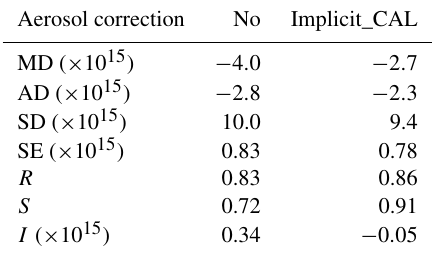
Table 5. Similar to Table 4 but for different aerosol corrections for aerosol-dominated conditions (a cloud radiance fraction less than 0.5, a cloud optical depth less than 5, and a cloud top height of less than 3km) for a total of 146 GOME-2 pixels. Results are calculated using DLER surface albedo and IFS (CBA) a priori